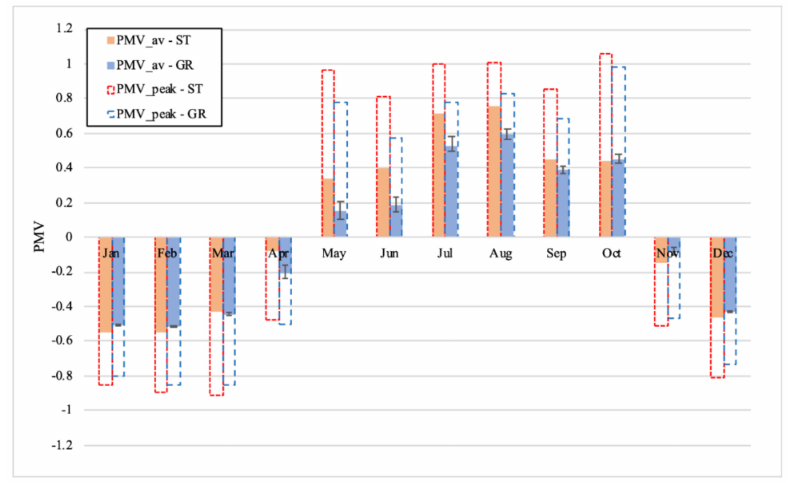
Figure 12. Monthly PMV average and peak values for Scenario #2 (GR) and Scenario #3